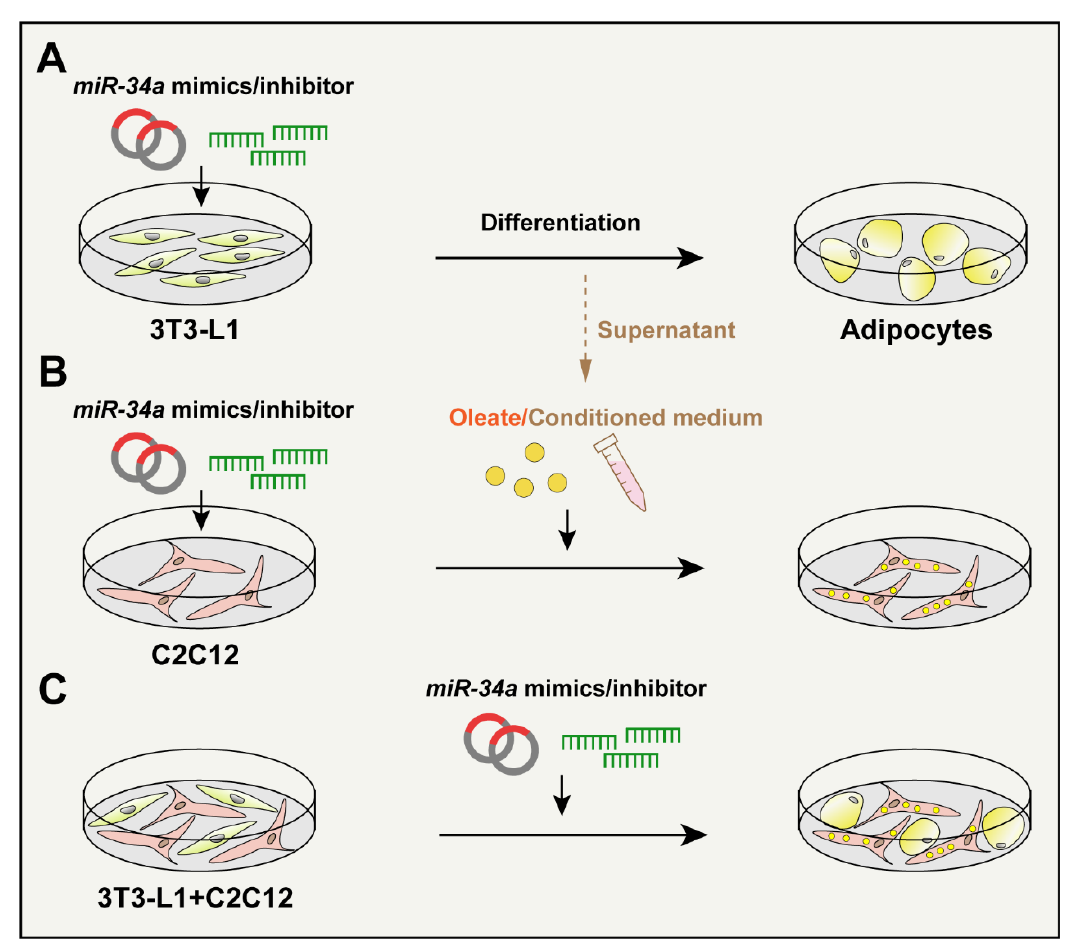
Figure 1. Cell culture and treatments. ( A ) 3T3-L1 cells were treated with miR-34a mimics or inhibitor (siRNA) and then were induced by adipocyte differentiation medium. ( B ) C2C12 cells were pre- treated by miR-34a mimics or inhibitor (siRNA) and treated with oleate or conditioned medium from the differentiation progress of 3T3-L1-derived adipocyte medium. The expression of adipogenic markers (i.e., Pparg , Cebpa , Fabp4, and Plin1 ) and the lipid droplet deposition in C2C12 cells were detected. ( C ) 3T3-L1 and C2C12 cells were co-cultured and treated with miR-34a mimics or inhibitor (siRNA) to detect the expression of adipogenic markers and lipid droplet deposition.